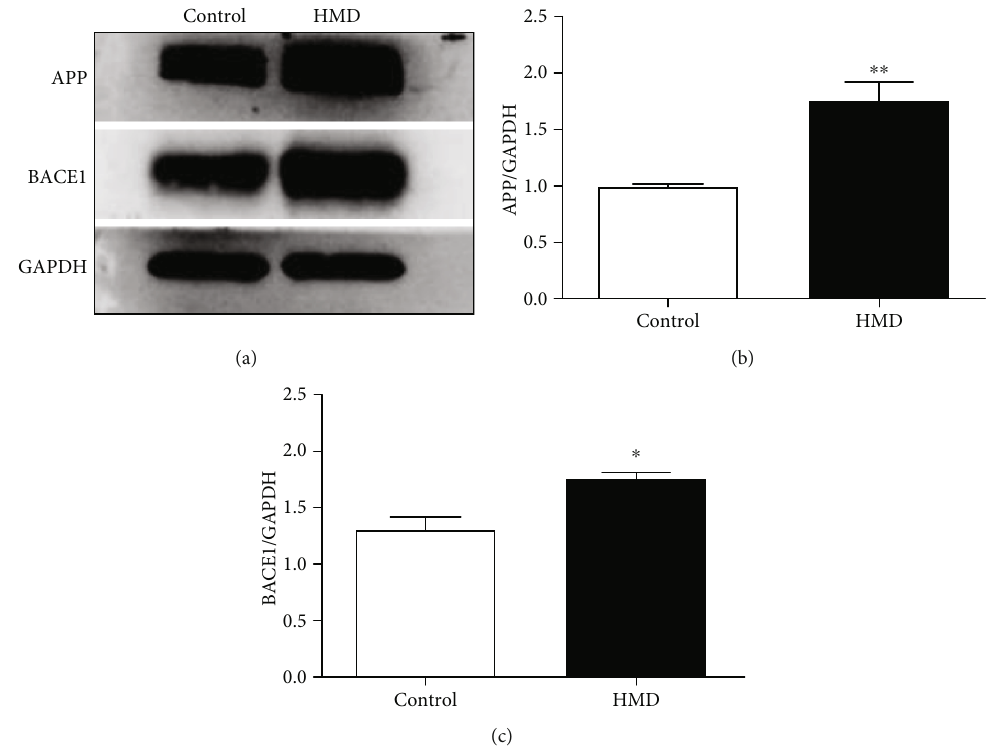
Figure 8: E ff ect of HMD on the expression of A β production-related proteins APP and BACE1 in cortex in mice. (a) Showed representative photomicrographs of APP and BACE1 proteins expression of each group in cortex. (b) The protein expression levels of APP in cortex. (c) The protein expression levels of BACE1 in cortex. Note: value was expressed as mean ± SEM ( n = 4 ). ∗ p < 0 : 05 vs. control